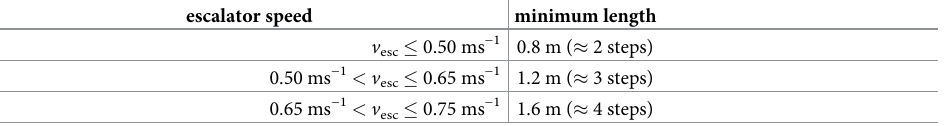
Table 2. Required length of the horizontal flights at the entrance and exit of an escalator according to norm EN 115–1